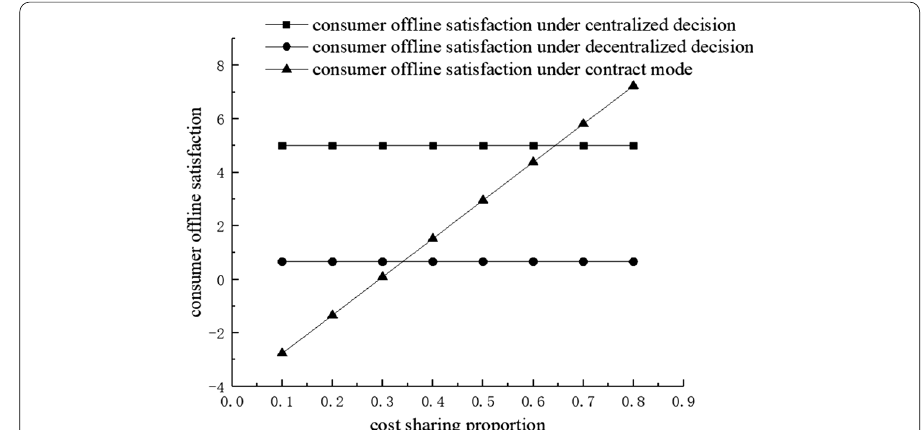
Fig. 10 Change of consumer offline satisfaction S 2 with cost share